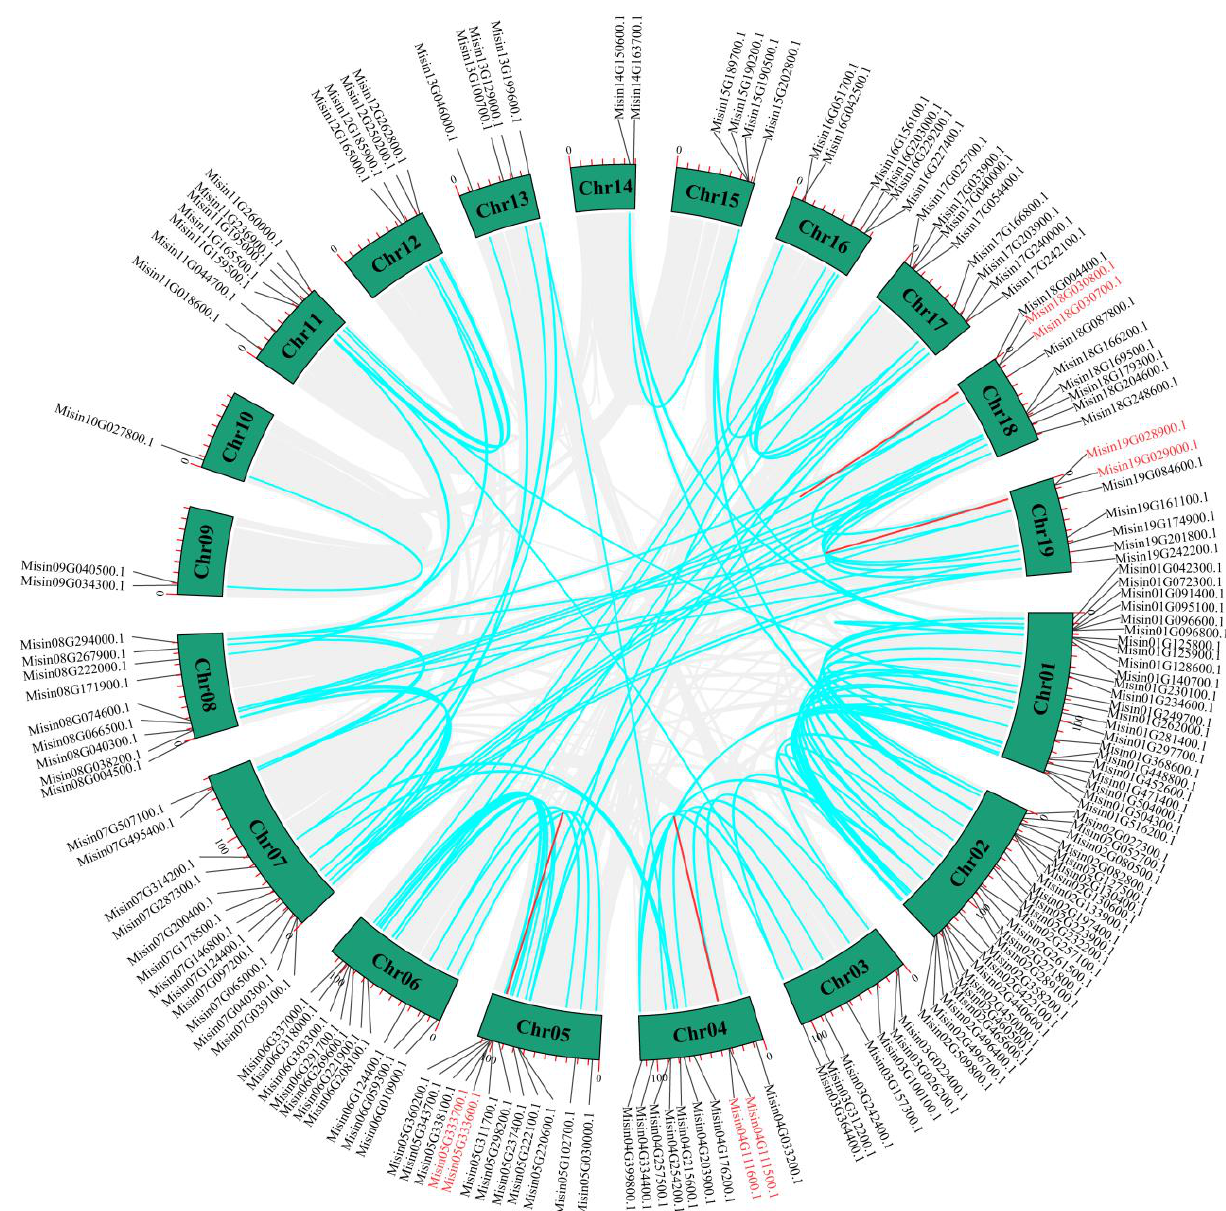
Figure 4. Diagrams depicting the interchromosomal relationship of M. sinensis HD-Zip genes. All synteny blocks in the genome were represented by gray lines, while segmental duplicates were shown by blue lines, and tandem duplicates were shown by red lines.